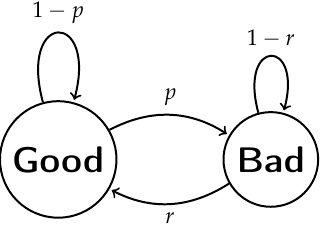
Figure 6. Gilbert-Elliott model